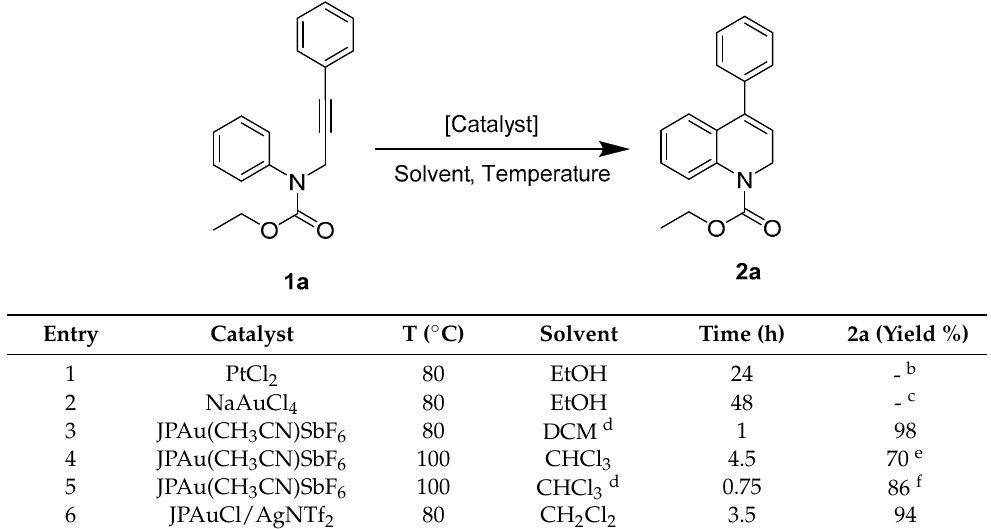
Table 1. Screening optimal conditions for the IMHA of the N -ethoxycarbonyl- N -propargylaniline 1a a .